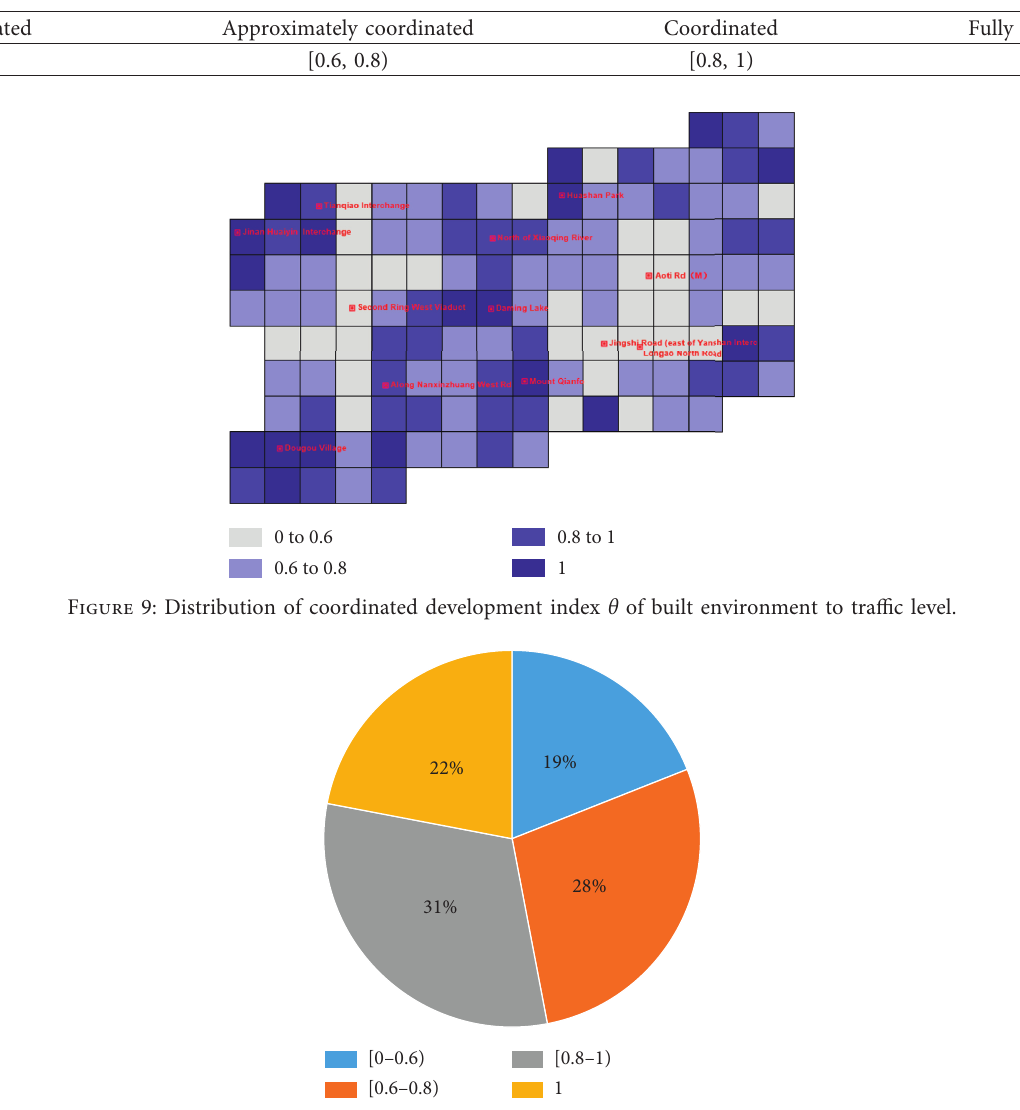
Table 2: Four grades of coordinated development index and coordinated development level.